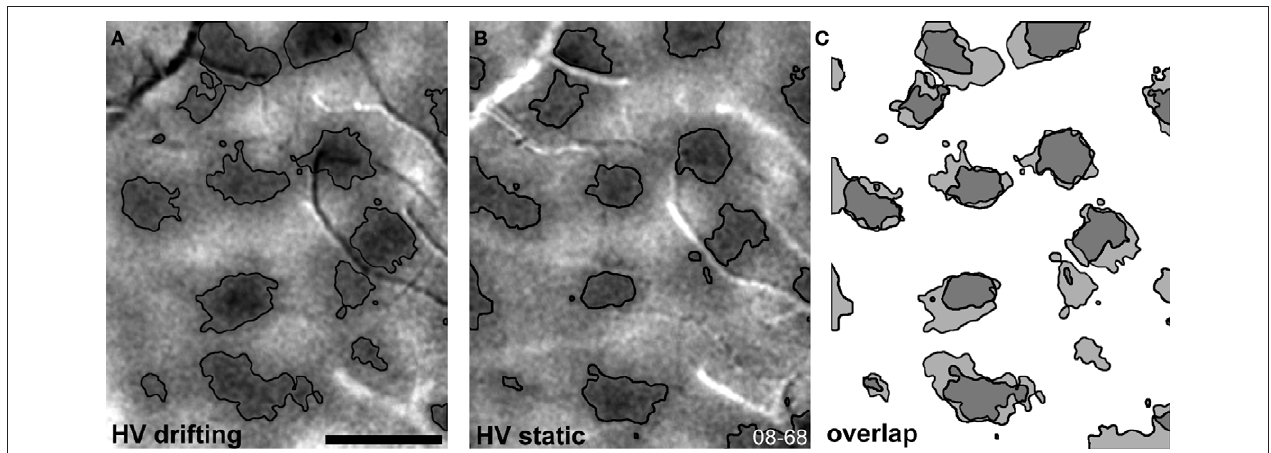
Figure 2 | Comparison of maps elicited by moving and stationary (flashed) gratings, case 08-68L. (A) A horizontal–vertical subtraction map is shown, produced from gratings drifting back-and-forth. Overlaid upon this map is a contour plot produced from a thresholded horizontal–vertical